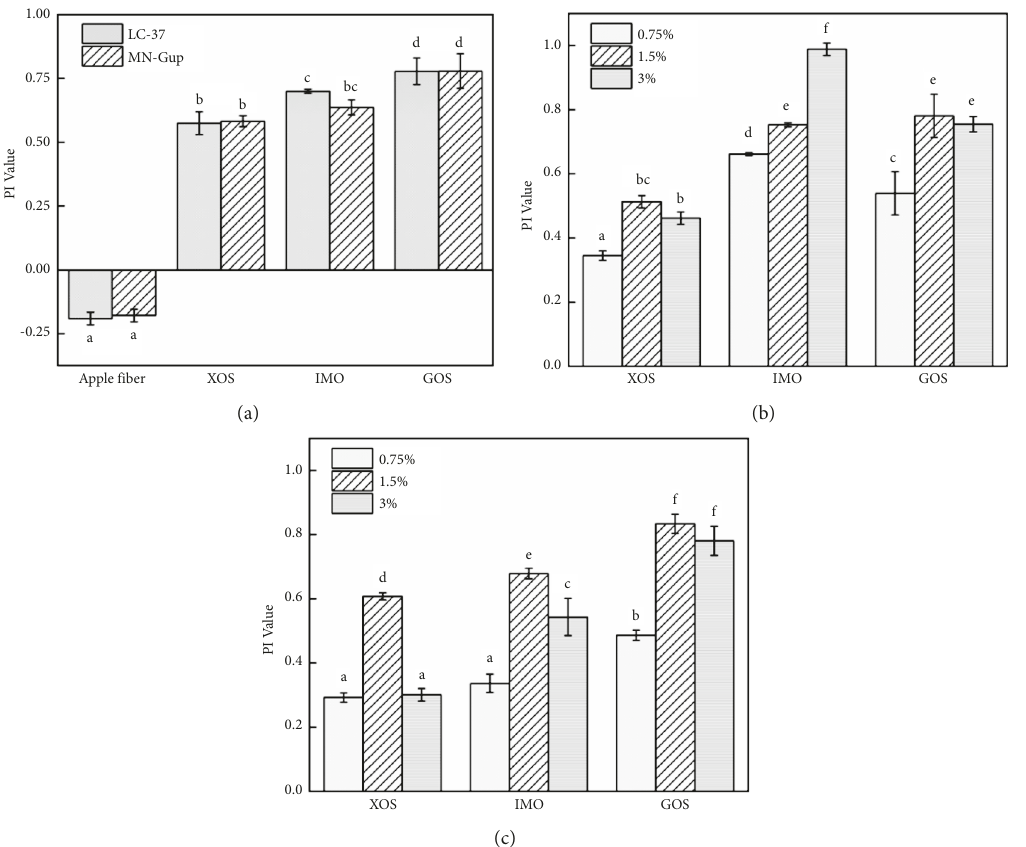
Figure 3: Prebiotic effects of different prebiotics on LC-37 and MN-Gup. (a) The prebiotic effects of apple fiber, XOS, IMO, and GOS with added contents of 1.5% on LC-37 and MN-Gup; (b) prebiotic effects of XOS, IMO, and GOS at different concentrations on LC-37; (c) prebiotic effects of XOS, IMO, and GOS at different concentrations on MN-Gup. Data are shown as means ± standard deviations (SD), and different lowercase letters indicate significant differences, p < 0 . 05 ( n �